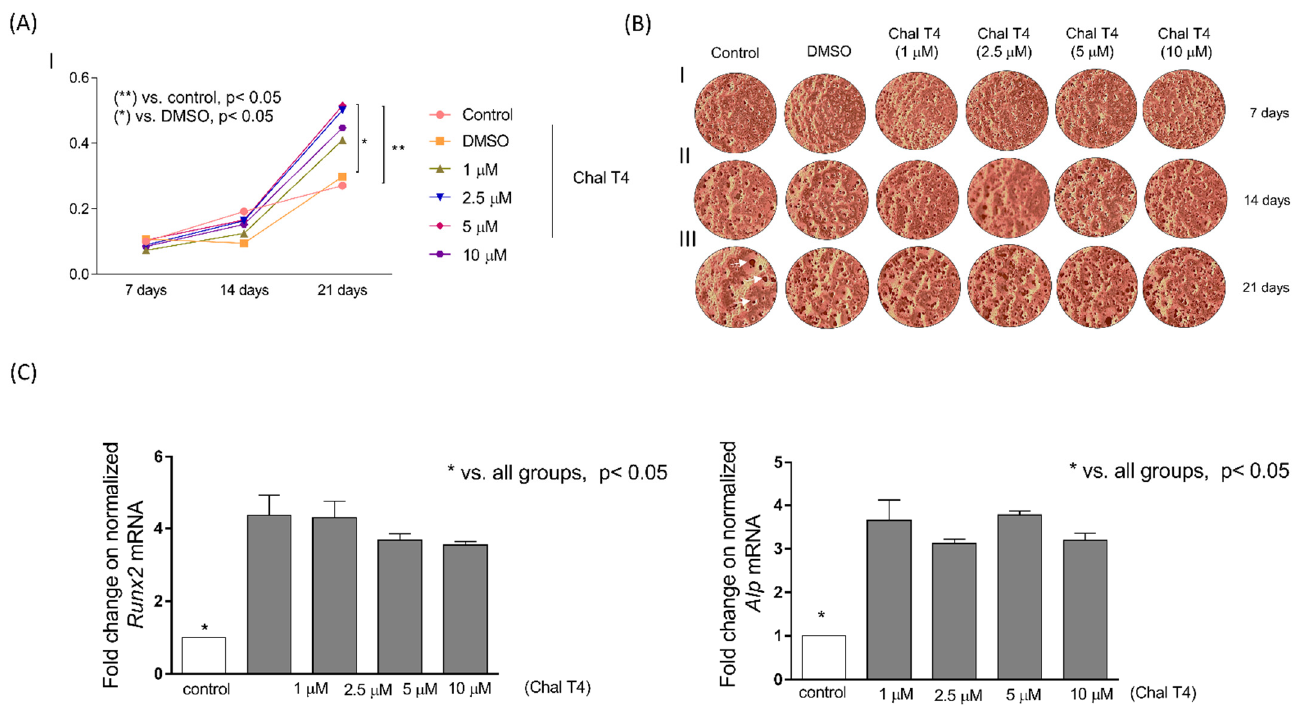
Figure 5. Chalcone T4 increases the formation of mineralized matrix nodules and gene expression of osteoblast markers. MC3TE-E1 were cultivated in osteogenic medium, and after 24 h treated with different concentrations of Chalcone T4. In ( A ), mean absorbance values at the end of each experimental period (7, 14 and 21 days). ( B ) Representative image of alizarin red staining. Images were registered on a digital inverted microscope (brightfield) (at a 40 × magnification). The arrows highlight the formed calcification nodules. ( C ) Gene expression of Alp and Runx2 in cells treated with the compound for 7 days. Bars indicate mean results and vertical lines the standard error (SEM) of three duplicate experiments.